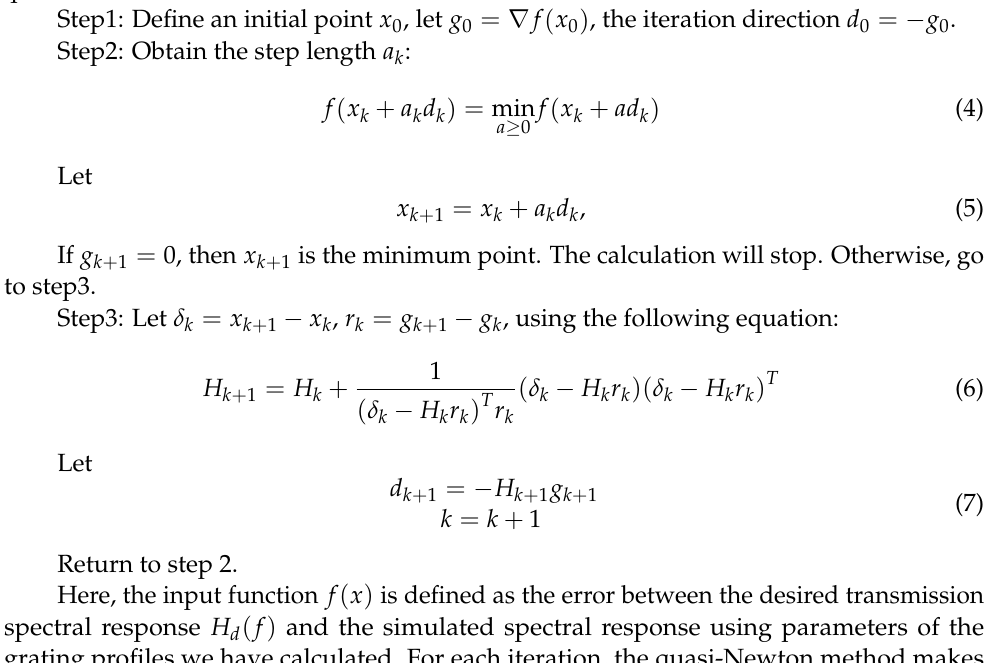
Figure 1. Amplitudes of transmission spectral response H d ( f ) corresponding to different orders. The coupling coefficients and grating periods of the designed PM-FBGs can be calculated using quasi-Newton optimization algorithm, which is an algorithm for finding local maxima and minima of an input function. The quasi-Newton method is an alternative of Newton’s method and is used when the Hessian matrix of the input function is unavailable or is too expensive to compute at every iteration [28]. The iteration steps of the quasi-Newton method are as follows: